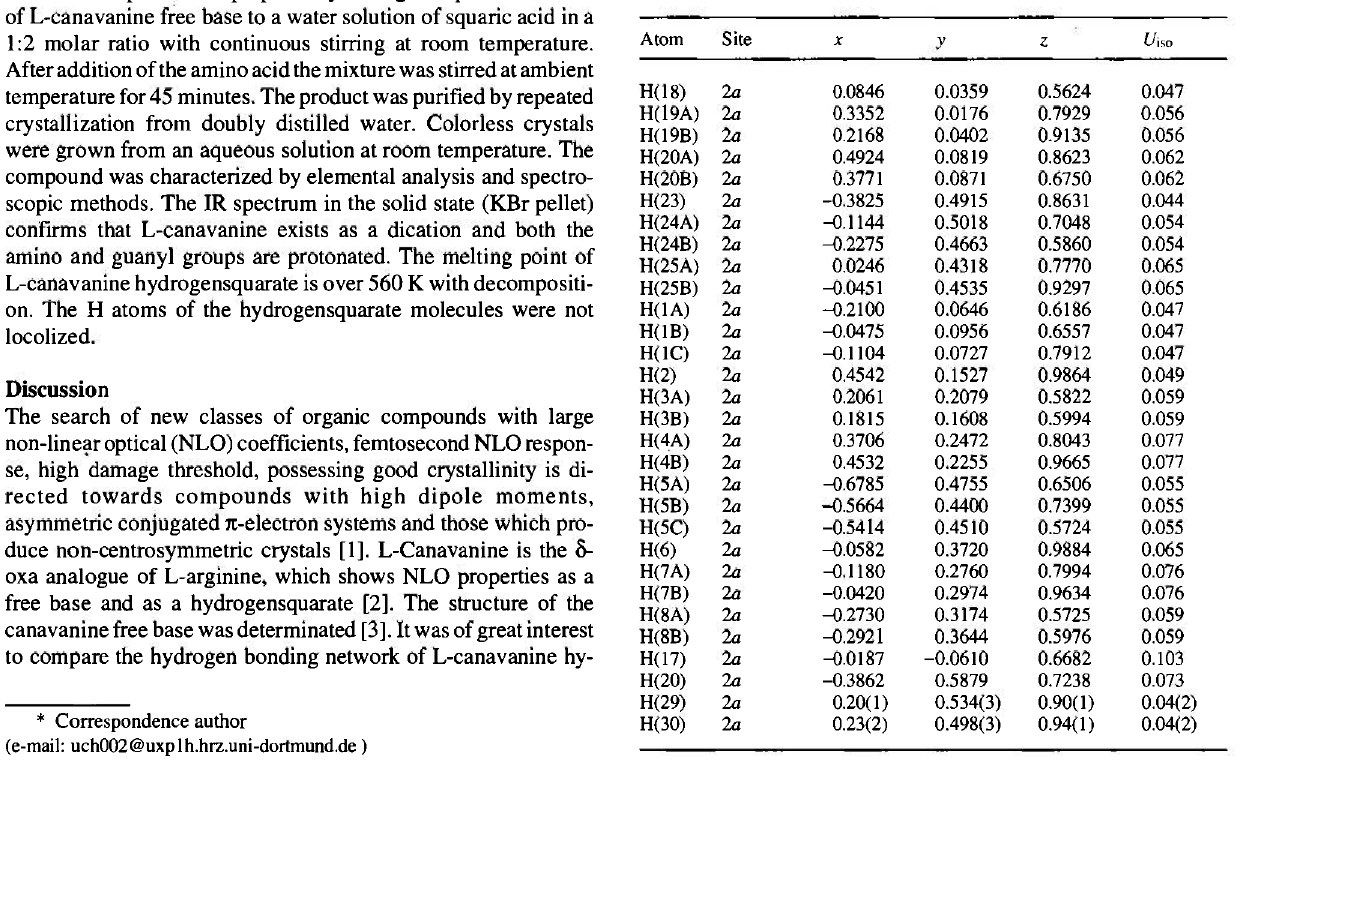
Table 2. Atomic coordinates and displacement parameters (in A 2